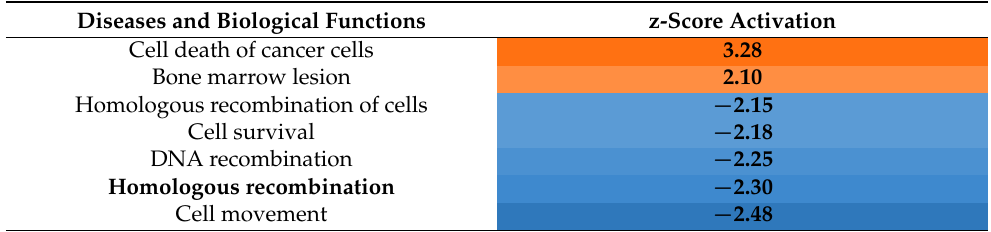
Table 1. List of the main differential diseases and biological functions. Activated or inhibited processes in the comparison of OCI-AML 3 shNS/OCI-AML 3 SCR cells. Table reports the predictive z-scores (orange: activation, z-score ≥ 2.00; blue: inhibition, z-score ≤ − 2.00). Color is proportional to z-score value. The homologous recombination biological function is highlighted in bold because it was further